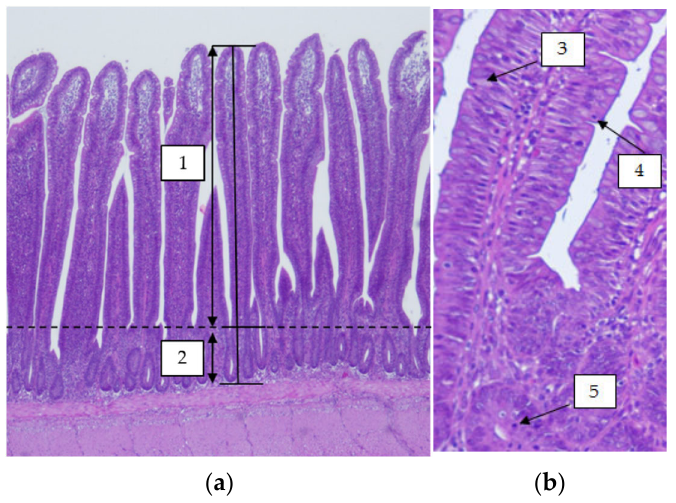
Figure 2. Histomorphometric measurements on ileum samples stained with hematoxylin and eosin. ( a ) Histological picture of 39 ‐ day ‐ old broiler chickens’ ileum at 40× magnification. Villus height (1) and crypt depth (2). ( b ) Histological picture of 10 ‐ day ‐ old broiler chicken at 100× magnification. Goblet cell (3), intraepithelial lymphocyte (4), and mitosis (5). Ileal contents on days 10 (5 birds/replicate) and 39 (1 bird/replicate) in Experiment 1,